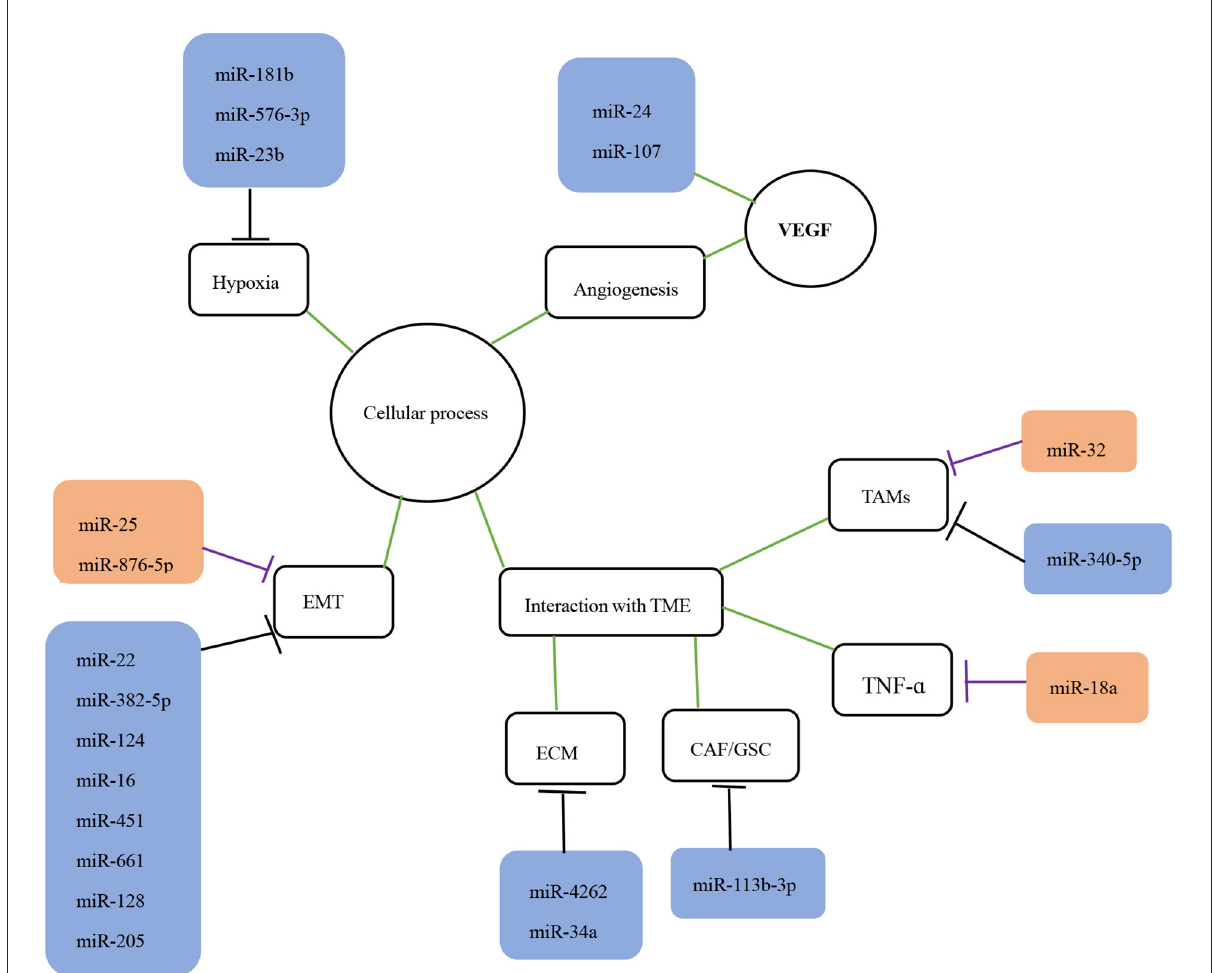
FIGURE1 The role of miRNAs in the invasion and migration of glioma. The role of miRNAs in glioma migration and invasion is shown. The black lines indicate suppression while purple lines indicate promotion of downstream targets or processes. The green lines indicate interaction with corresponding processes or molecules. EMT, epithelial-mesenchymal transition; TME, tumor microenvironment; TAMS, tumor-associated macrophages; VEGF, vascular endothelial growth